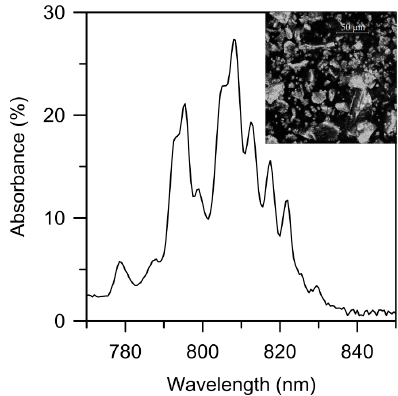
Figure 1. A microscope photograph (inset) and absorbance spectrum of Nd:YAG crystal powder corresponding to the 4 I 9/2 → 4 F 5/2 transition. The average grain size is of the order of tens of microns.